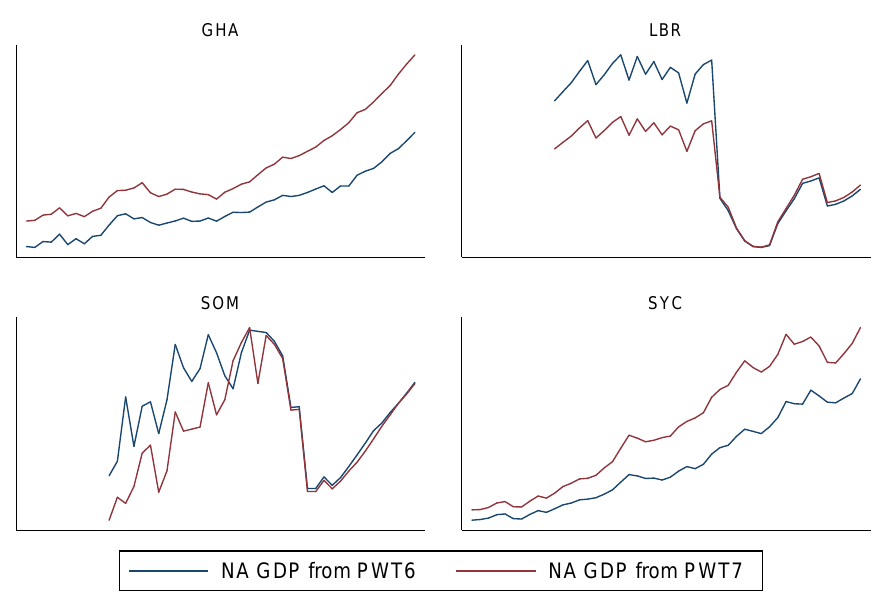
Figure 6: GDP from underlying NA data,